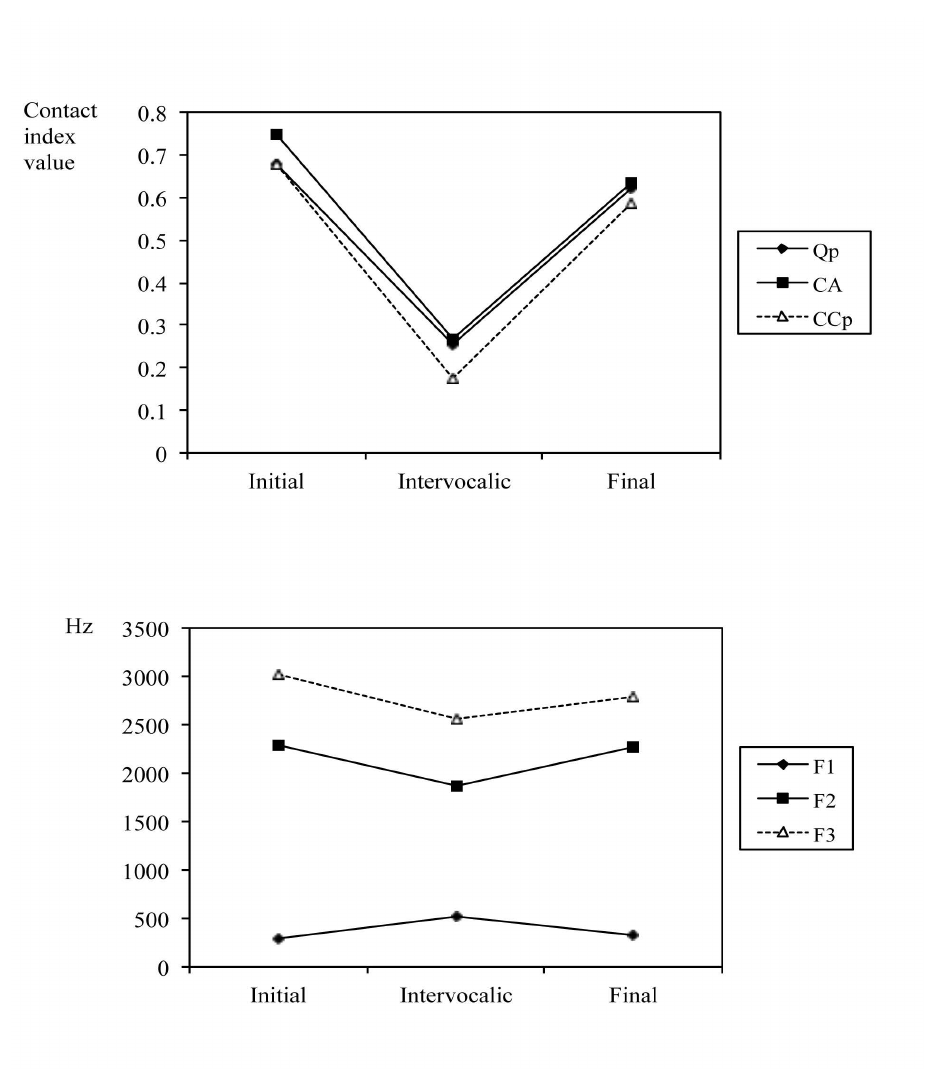
FIGURE 2. Contact index values (Qp, CA, CCp; top) and formant frequency values (F1, F2, F3; bottom) for [j] as a function of word position across